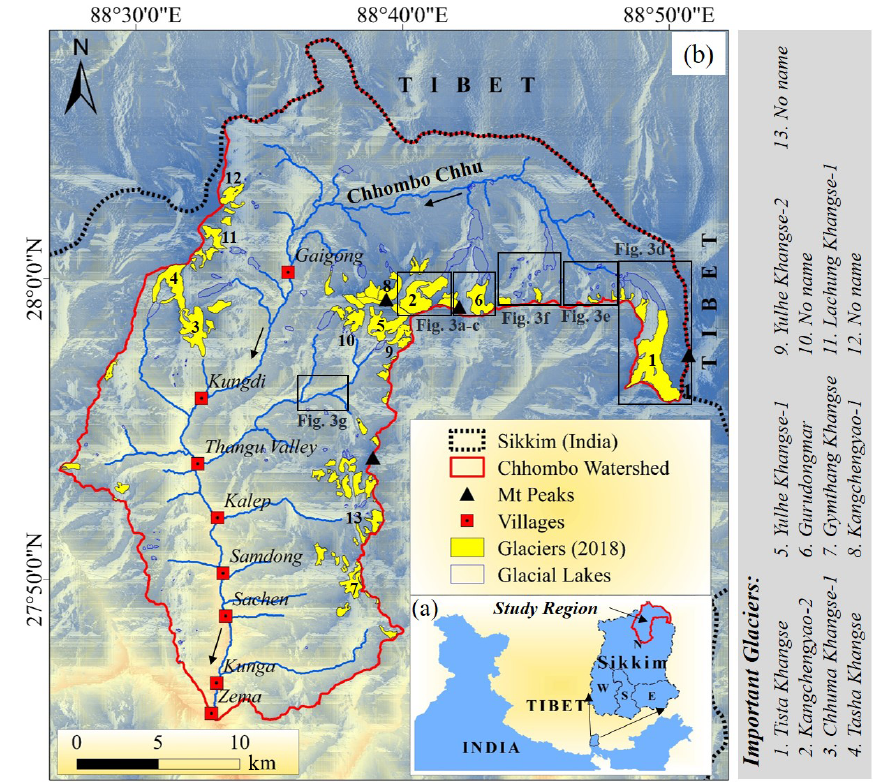
Figure 1. (a) Location of the Chhombo Chhu Watershed in the eastern Himalaya. The watershed boundary is marked in red in the inset within Sikkim. (b) Glacier and glacial lake distribution in the CCW in the Sikkim Himalaya. Black boxes represent the field measurement sites in 2017–2018. The base map used here is a Shuttle Radar Topography Mission (SRTM) DEM.